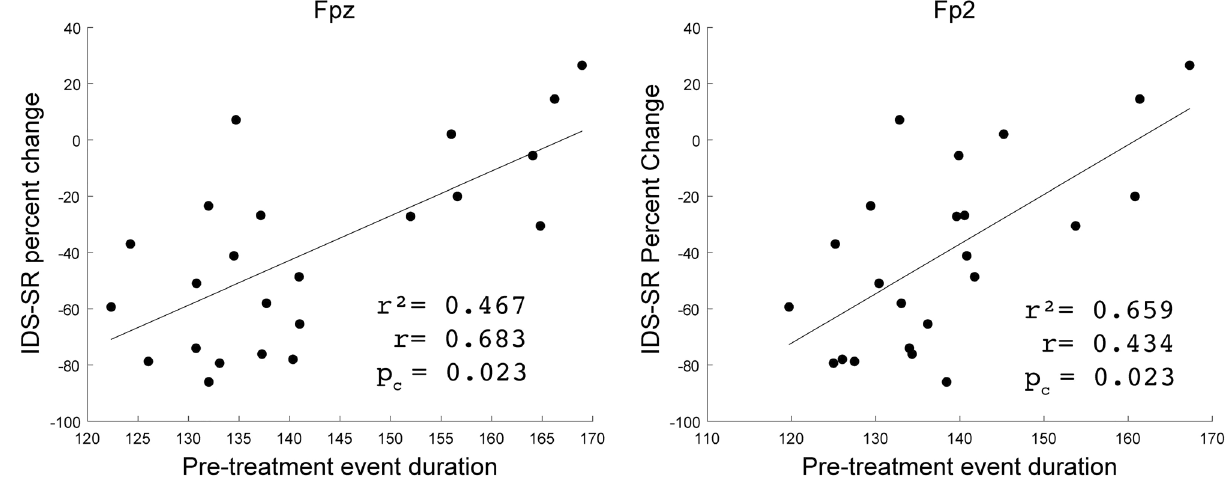
Figure 6. Correlation between IDS-SR percent change and pre-treatment beta event duration from the Fpz and Fp2 electrodes for each patient (•). Pearson’s correlation coefficient r, r 2 , and BH-adjusted p-values